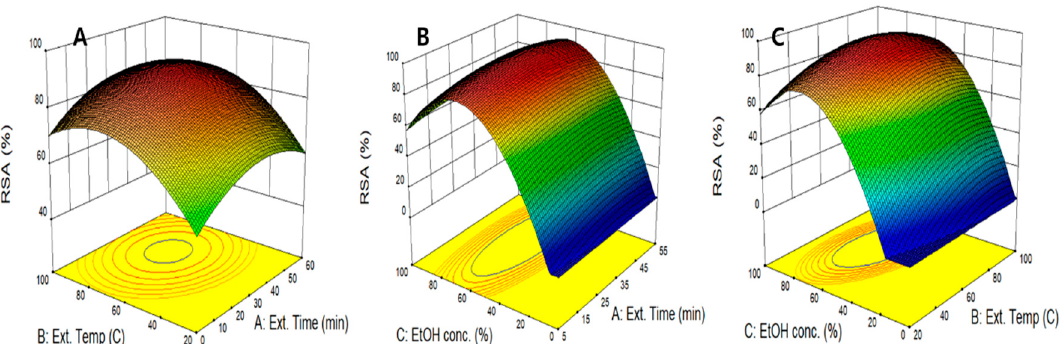
Figure 2. Response surface plots for RSA of peanut shell extract according to extraction time, extraction temperature, and ethanol concentration. RSA as a function of extraction temperature and extraction time ( A ), extraction time and ethanol concentration ( B ), and extraction temperature and ethanol concentration ( C ).